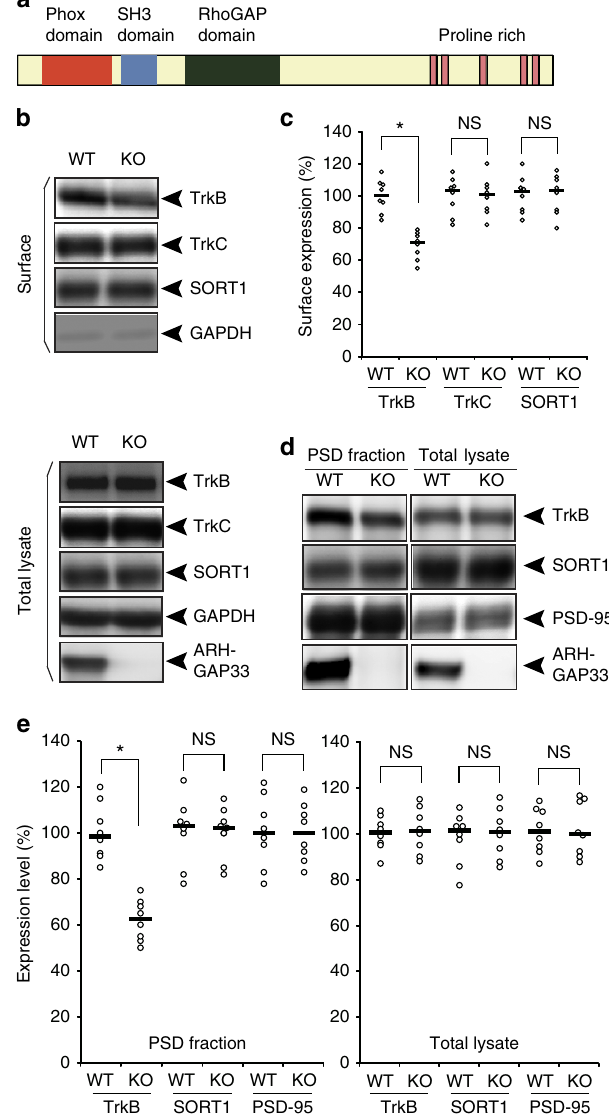
Figure 1 | Impaired TrkB trafficking to the cell surface at synapses